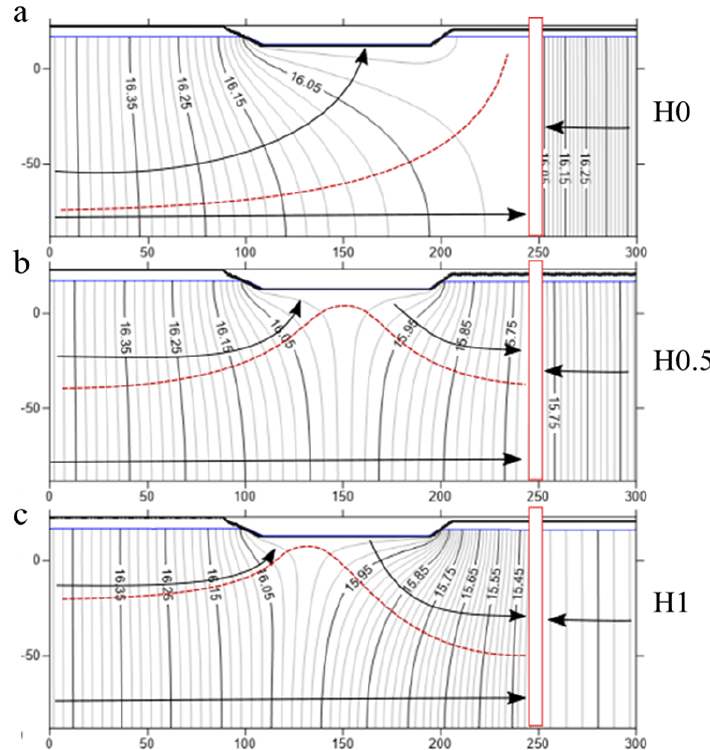
Figure 5. Modeling results for 100 m of saturated zone below the river without clogging of the streambed, and with a constant pumping rate (Q = 0.001, Ar = 1) in steady state flow (Sim$2.1, Sim$2.2 and Sim$2.3, Table 2). The right fixed head boundary is variable, with 16.5 m ( a ), 16 m ( b ) and 15 m ( c ). The gray line represents the piezometric lines (0.1 m steps), the blue line represents the water table geometry, the black arrow represents the streamlines, and the red lines are the GW divide.